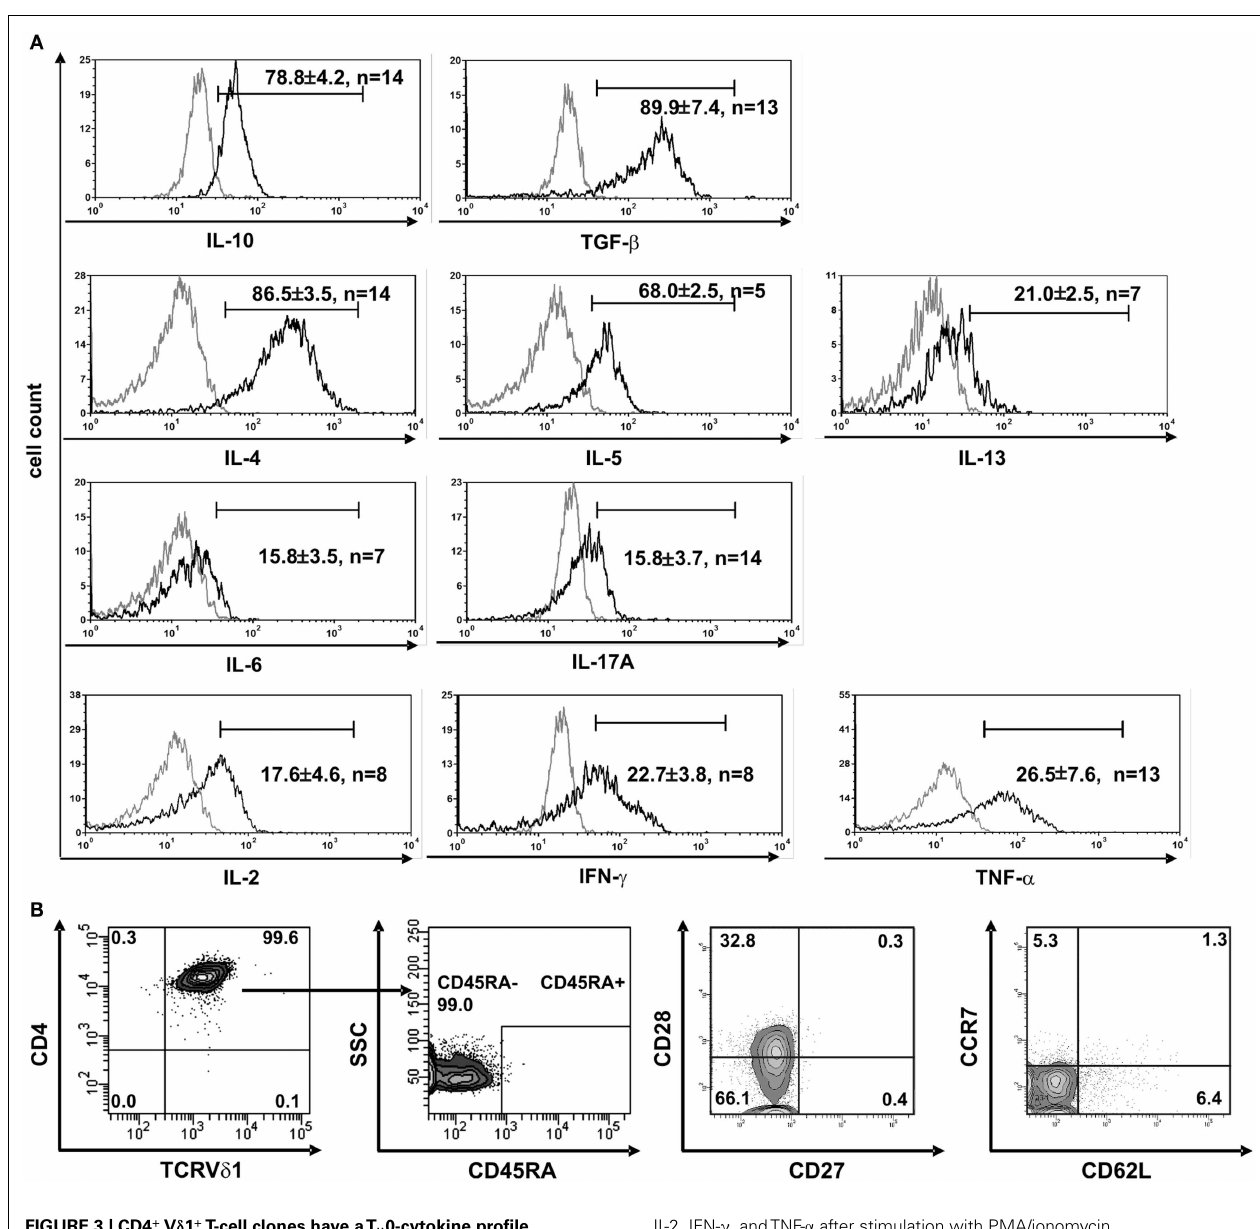
FIGURE 3 | CD4 + V δ 1 + T-cell clones have aT H 0-cytokine profile and are effector-memory cells . (A) CD4 + V δ 1 + clones produce regulatory IL-10 andTGF- β ,T H 2 cytokines IL-4, -5, and -13, and to a lesser extent proinflammatory IL-17A and IL-6, and theT H 1-cytokines